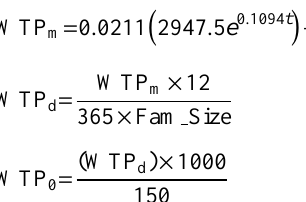
Figure 6. Dynamic simulation model in iThink.